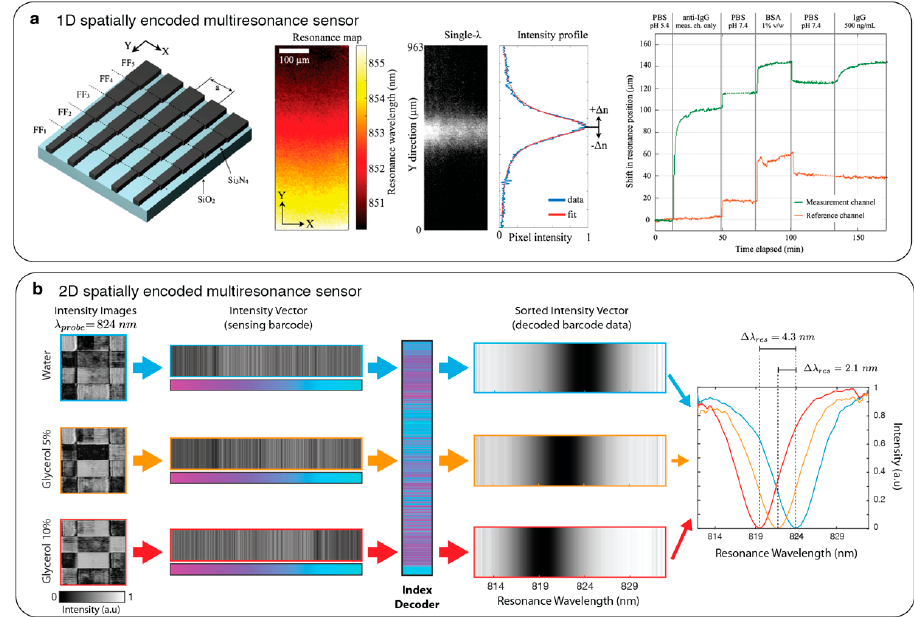
Figure 5. Spatially encoded spectral interrogation with multi-resonance nanophotonic sensors. ( a ) (left) Chirped guided-mode resonant grating where spectral resonance position is encoded in Y-axis as shown in the resonance map. (middle) Bright-field image of the grading and its corresponding intensity profile when illuminated with monochromatic light. (right) Temporal resonance position plot in an in-flow bioassay. Adapted with permission from [76]. © 2017 Optical Society of America; ( b ) barcode-based sensing encoding the high-Q resonance positions of dielectric metasurfaces into 2D multiresonance sensors. (Left to right) Monochromatic intensity images of a multiresonance sensor in the presence of different top-media, their corresponding sensing barcodes, index decoder, decoded barcodes and the spectra showing the resonance shifts in accordance with the top media refractive index. Adapted with permission from [29]. Copyright 2019 Nature Publishing Group.